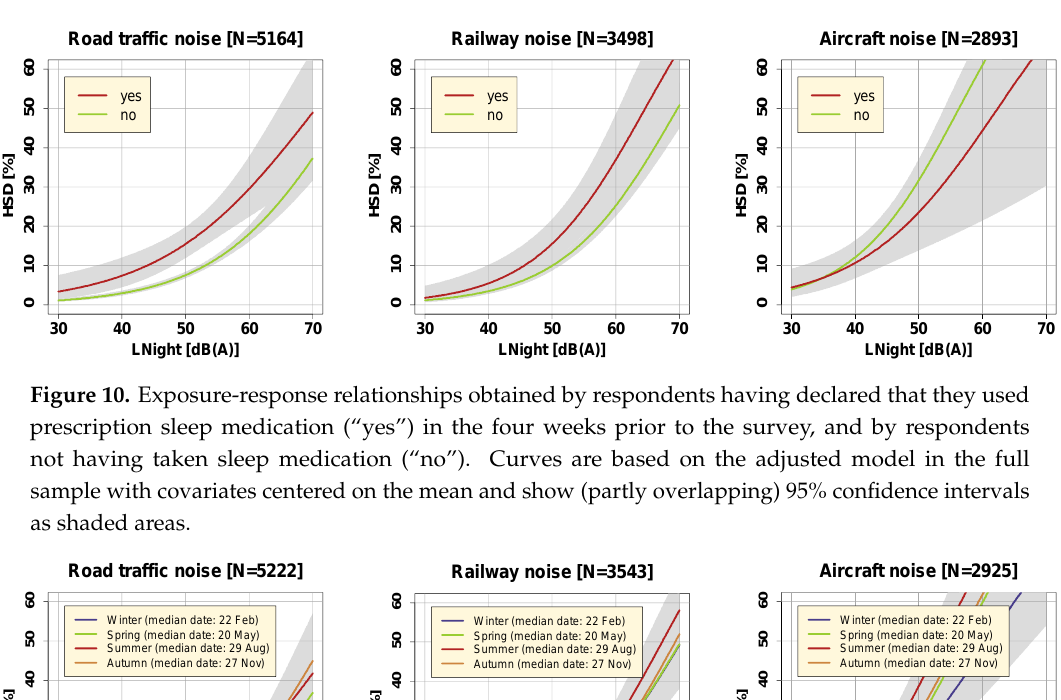
Figure 10. Exposure-response relationships obtained by respondents having declared that they used prescription sleep medication (“yes”) in the four weeks prior to the survey, and by respondents not having taken sleep medication (“no”). Curves are based on the adjusted model in the full sample with covariates centered on the mean and show (partly overlapping) 95% confidence intervals as shaded areas.